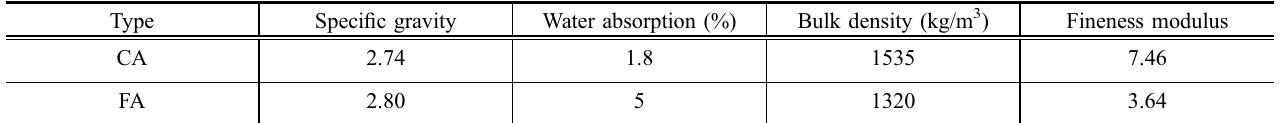
Table 1 Aggregate properties.